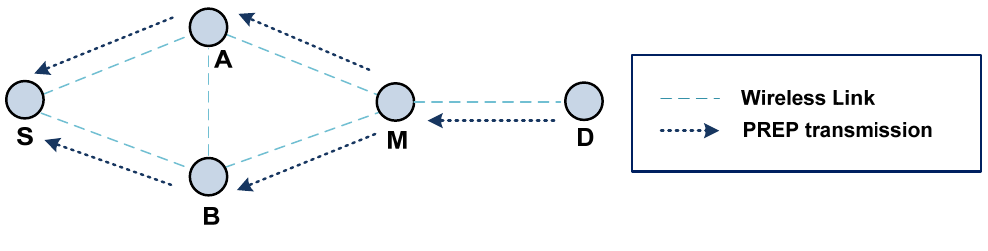
Figure 9. Example of an impersonation attack (loop).